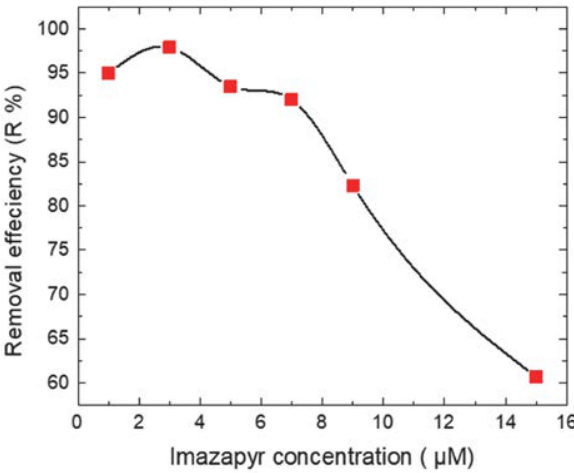
Figure 4: Removal efficiency of imazapyr as a function of imazapyr concentration, mcatalyst = 100 mg; stirring speed = 1000 min –1 , aqueous suspension 1 : 3 acetone/ Milli-Q